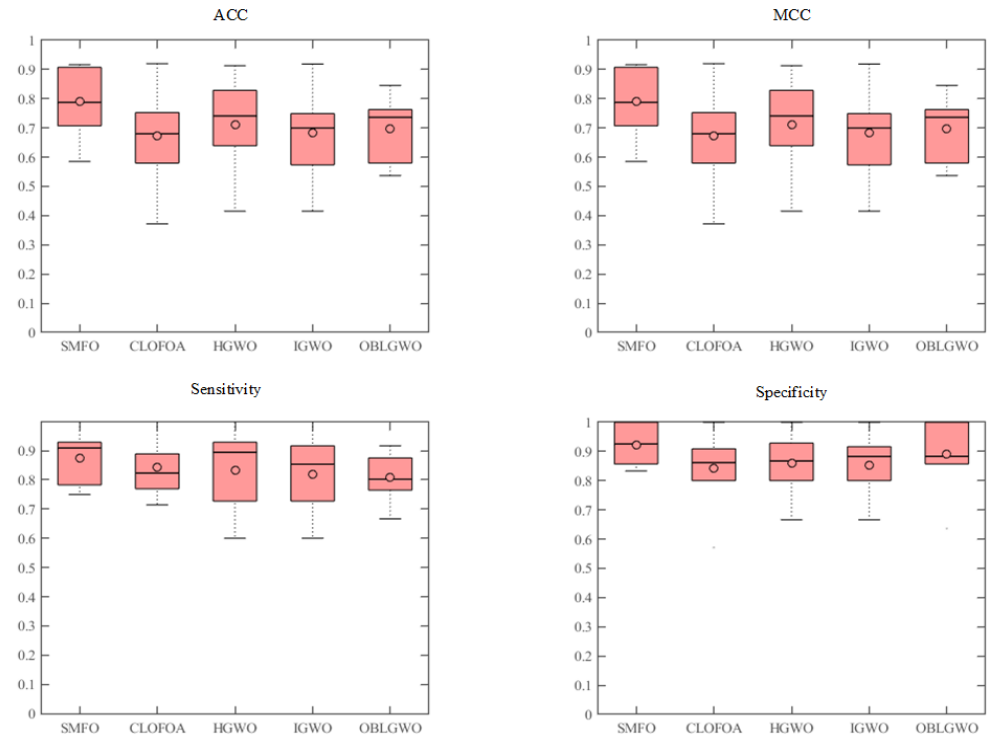
Figure 7. Boxplot of SMFO-KELM and its advanced algorithm competitors of ACC, MCC, sensitivity, and specificity on Son La dataset.